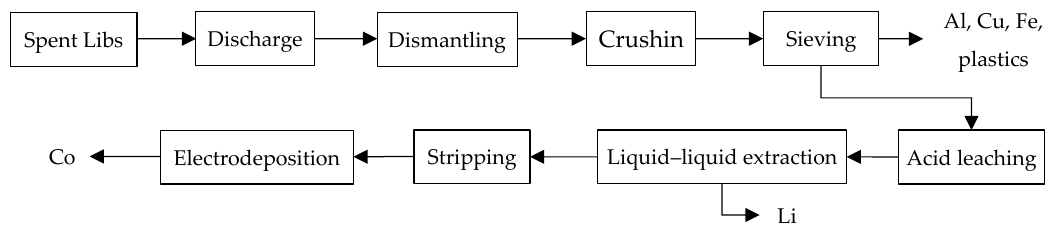
Figure 1. Experimental procedure for recovery of cobalt.